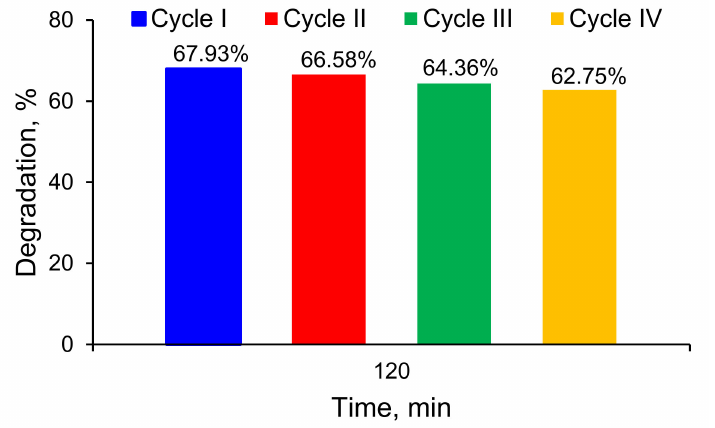
Figure 12. Variation of 2,4 DNP photodegradation efficiency within four consecutive reaction cycles on TiO 2